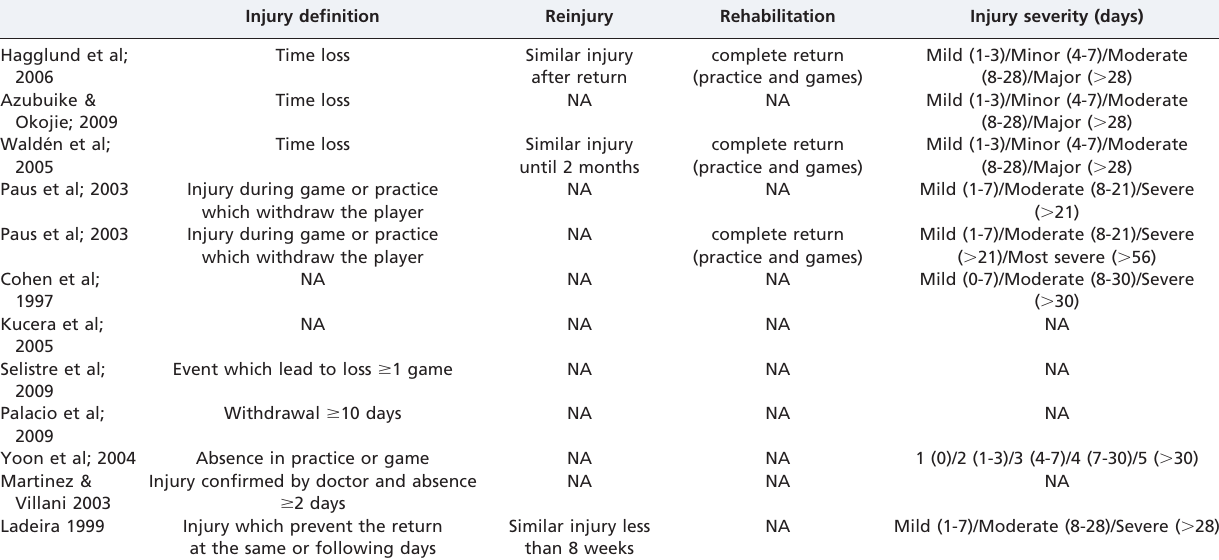
Table 3 - Characteristics of the studies selected for final inclusion.